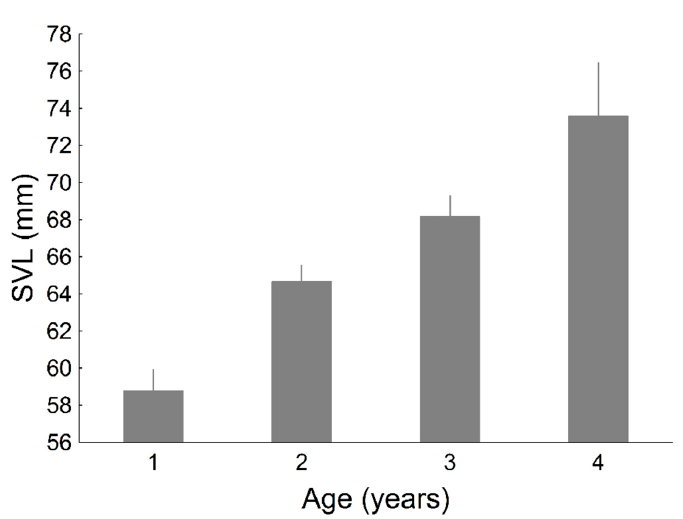
Figure A1. Average snout ‐ vent length (SVL) of P. algirus lizards according to age estimated with skeletochronology. Lines indicate the starndard error.